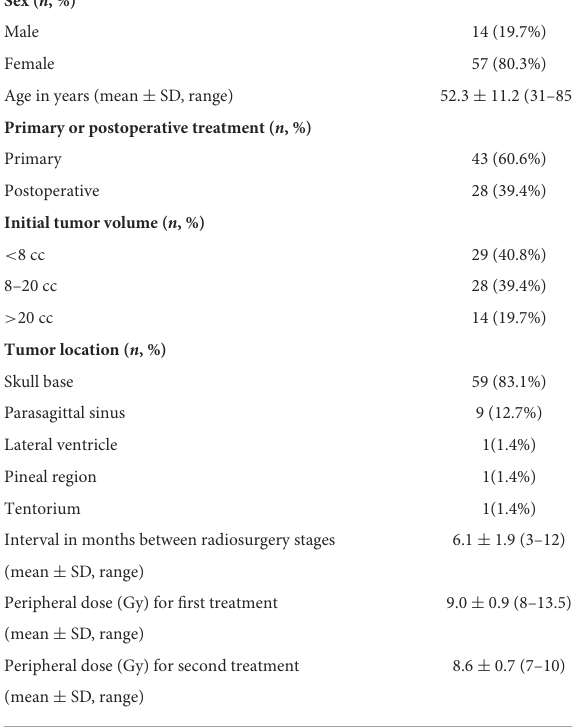
TABLE 1 Characteristics of the 71 patients in this